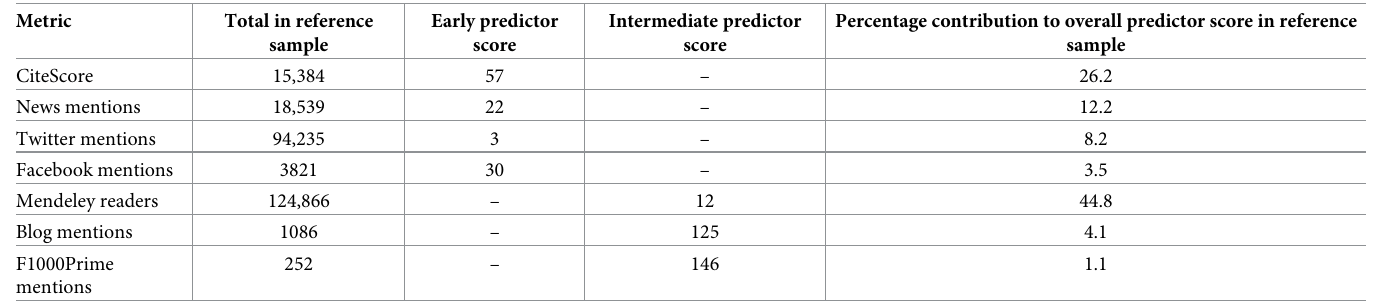
Table 3. Weightings assigned to metrics included in the early and intermediate predictor